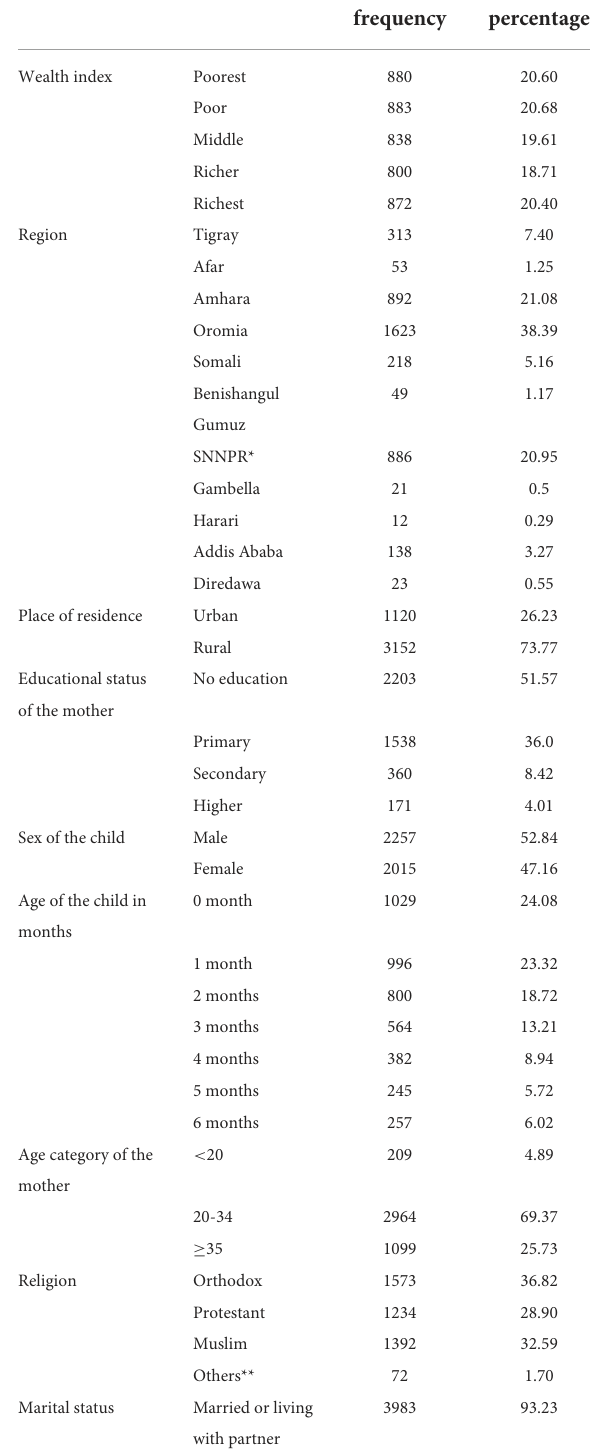
TABLE 1 Socio-demographic and reproductive health characteristics of women and children enrolled in the analysis of the